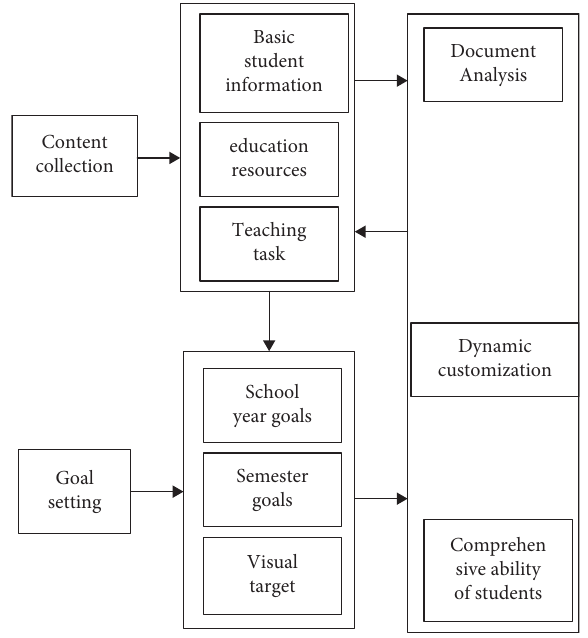
Figure 6: Data collection of ideological and political learning teaching